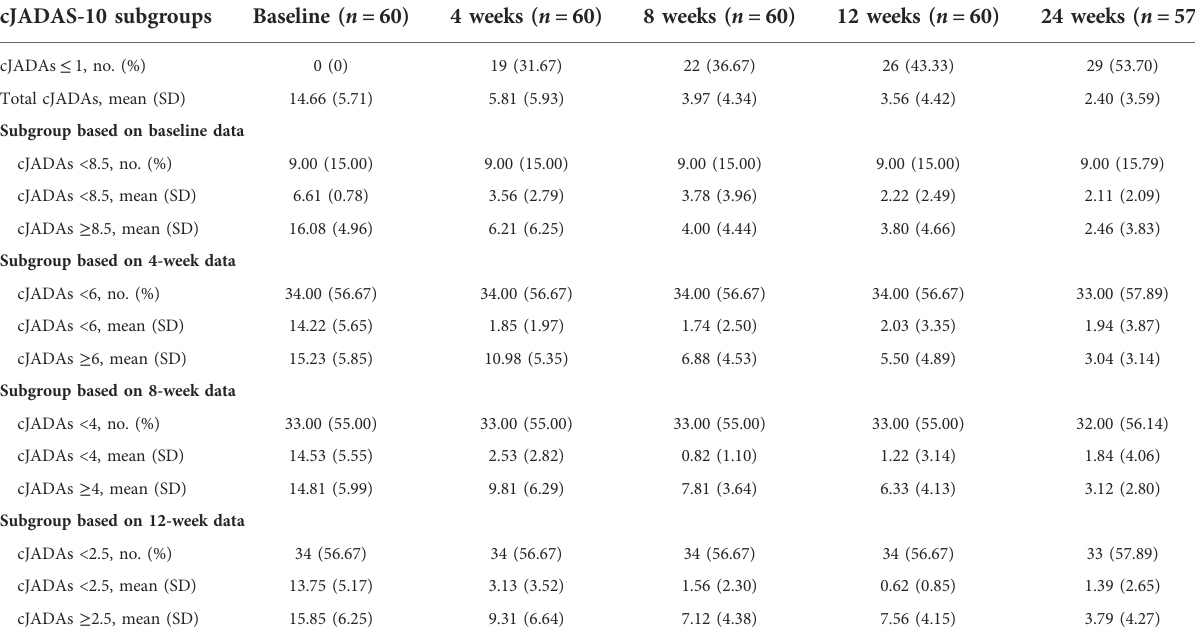
TABLE 2 Clinical characteristics of various cJADAS-10